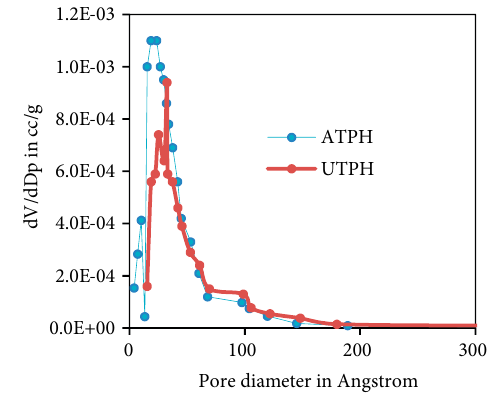
Fig. 9. Pore diameter distribution of acid treated peanut husk (ATPH) and untreated peanut husk (UTPH)